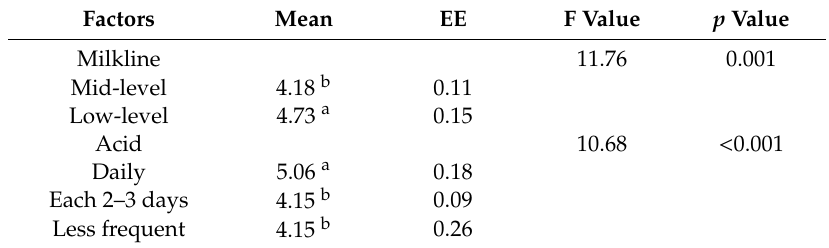
Table 4. Least squares means of the counts of lactic microbiota in milk (log 10 CFU / mL) from Manchega dairy sheep farms for factors included in the best fitting mixed